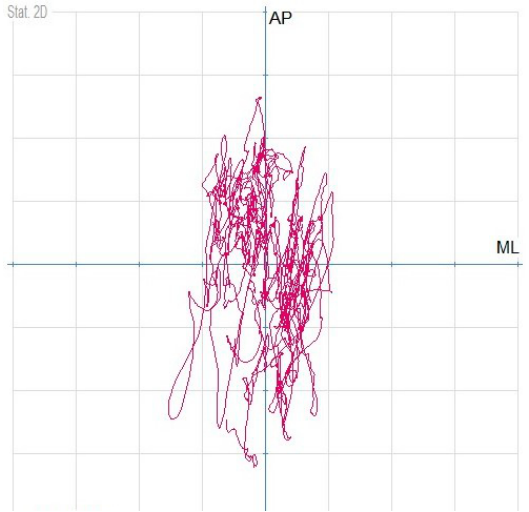
Figure 2. Diagram showing path length sample for COP during EC L test.